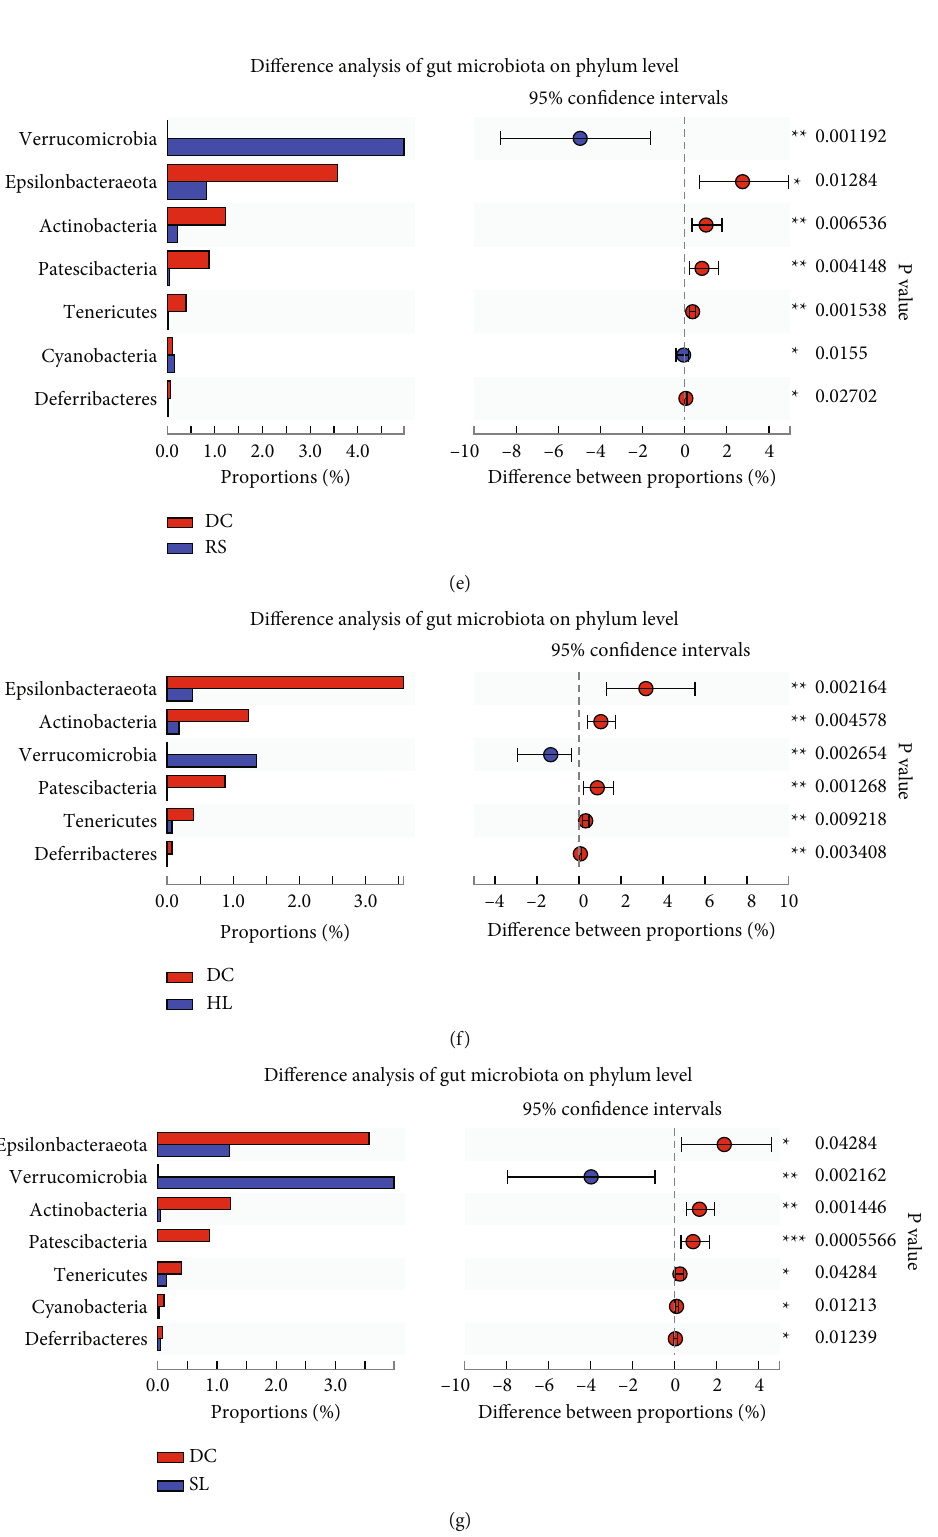
Figure 3: (a) Principal coordinate analysis (PCoA) of gut microbiota for mice. Weighted UniFrac PCoA plot and based on OTU abundance, each point represents the placenta microbiota of a sample, with main principal component (PC) scores: PC1 = 33 : 52 % and PC2 = 13 : 26 % . (b) The boxplot represents the dispersion of distribution of di ff erent groups of samples on PC1. Relative abundance of phylum level was signi fi cantly di ff erent among (c) NC, (d) Met, (e) RS, (f) HL, (g) SL, and DC groups, ∗ P < 0 : 05 , ∗∗ P < 0 : 01 , compared with the DC